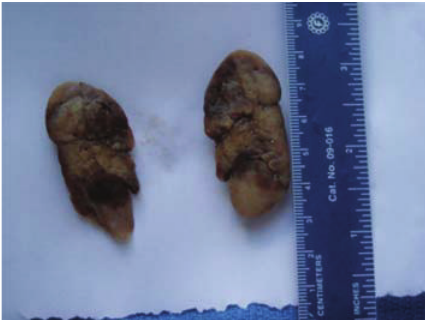
Figure 5: Gross specimen of a bisected parathyroid adenoma.